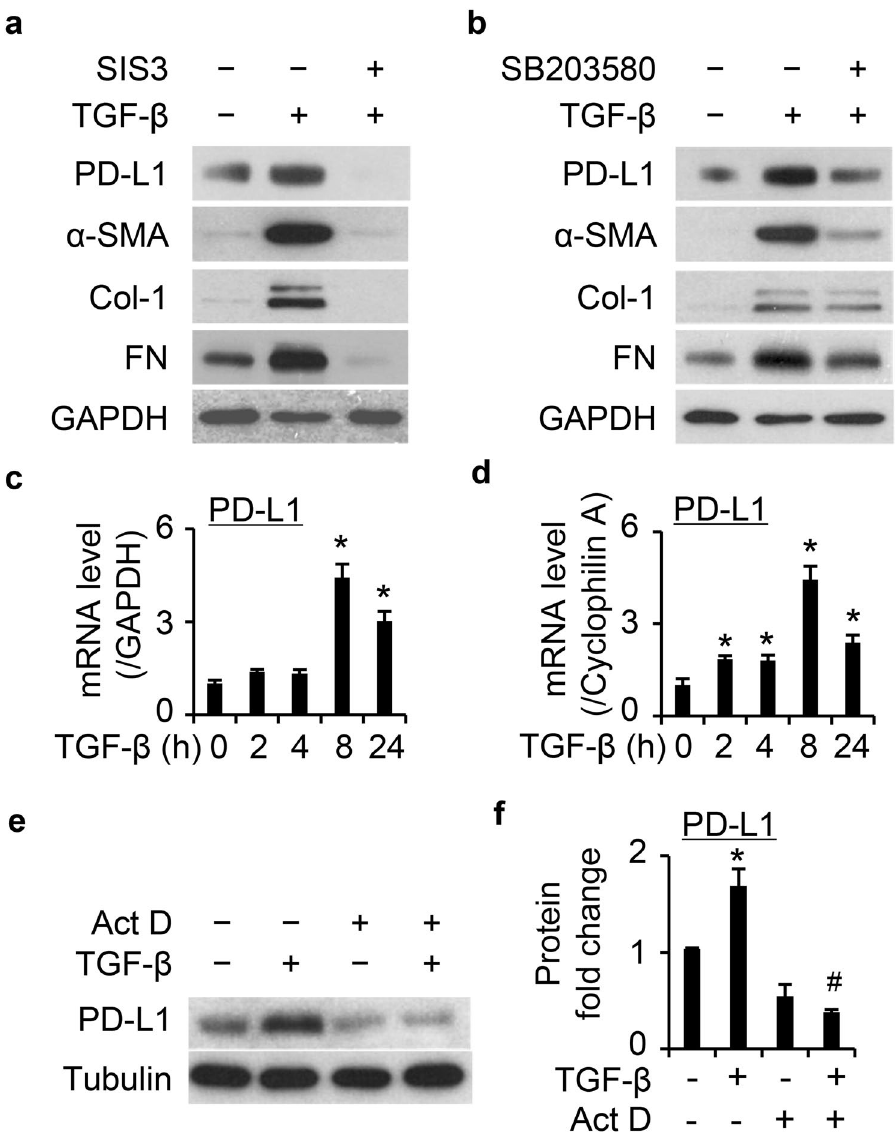
Figure 5. TGF-β upregulates PD-L1 at the transcriptional level and in Smad3 and p38 dependent manner. ( a ) and ( b ) pretreatment with Smad3 inhibitor SIS3 (10 µM) ( a ) or p38 inhibitor SB203580 (10 µM) ( b ) for 30 min abolished/attenuated the induction of PD-L1 and FMT markers in primary normal HLFs. ( c ) qPCR data showed that TGF-β (5 ng/mL) induced PD-L1 mRNA expression in a time dependent manner in primary normal HLFs, which was significantly increased after 8 h treatment. GAPDH was used as a reference gene. ( d ) Similar result was found as in ( c ) using a different reference gene cyclophilin A. ( e ) Pretreatment with 1 µg/mL Actinomycin D (Act D) for 30 min blocked TGF-β (5 ng/mL) induced expression of PD-L1 in the primary normal HLFs. ( f ) The quantification of the data illustrated in ( e ) based on three independent experiments. ImageJ software was used to quantify the band intensity. *, P < 0.05 vs. control group. #, P < 0.05 vs. TGF-β-treated control